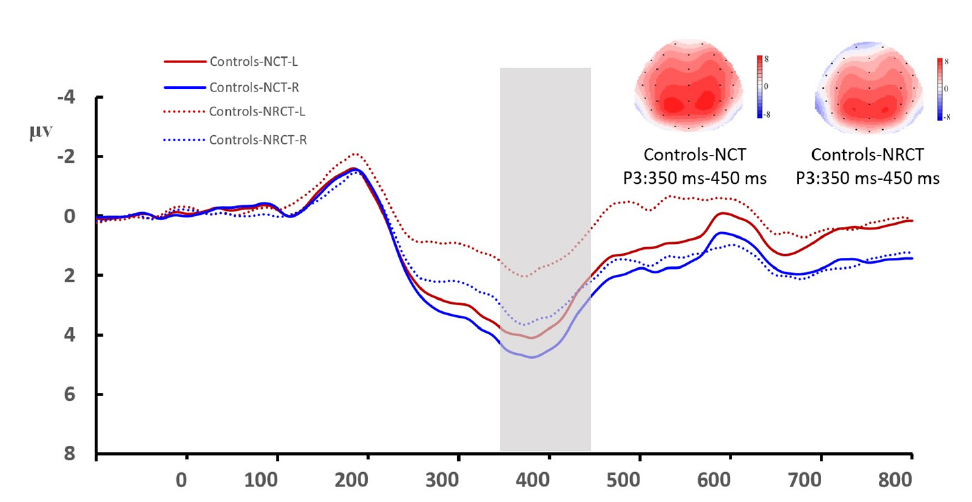
Figure 4. Mean amplitude of the P3 component in the two hemispheres in the control group. Averaged data of the left hemisphere are from the F3, F7, FT3, FT7, CP3, and P3 electrodes. Averaged data of the right hemisphere are from the F4, F8, FT4, FT8, CP4, and P4 electrodes. The topographies correspond to average activity in the time window of 350–450 ms (indicated by the gray bar) around the local peaks. NCT: notch circle task; RNCT: rotating-notch circle task.